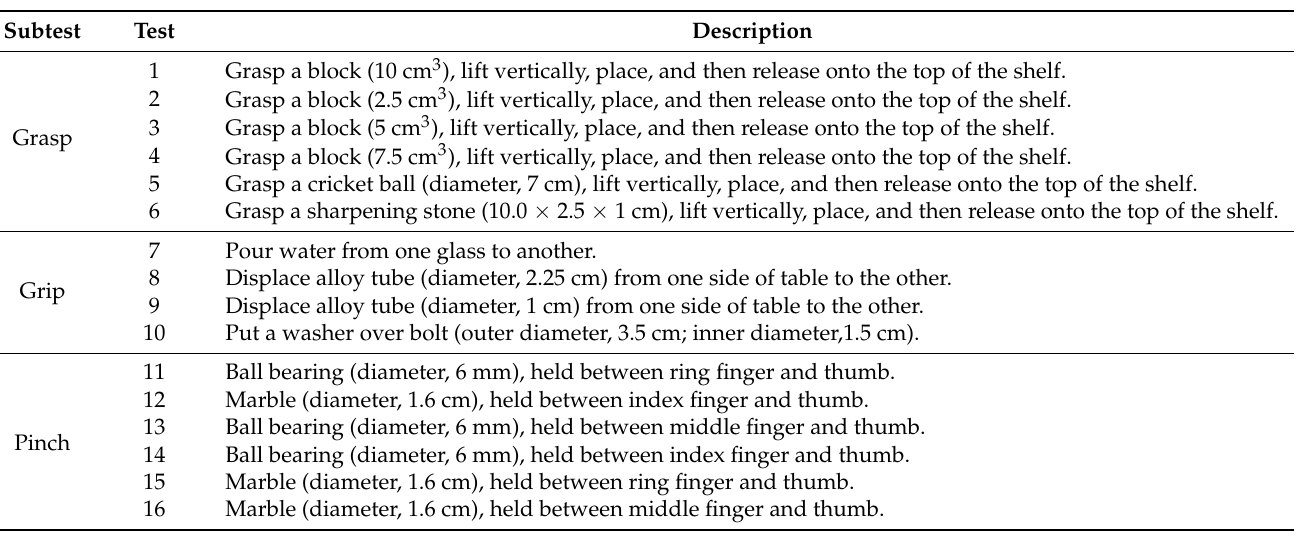
Table 2. Description of the sixteen tests